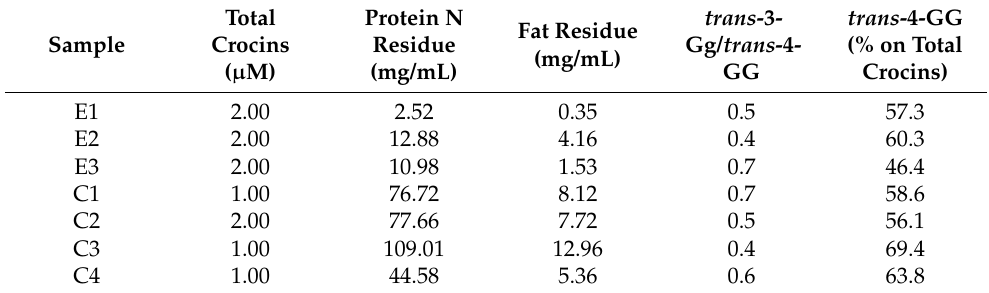
Table 2. Main characterization of the crocin-rich extracts incubated on the cellular lines: total crocins ( µ M) incubated; residual protein nitrogen (mg/mL) and fat (mg/mL); trans -3-Gg/ trans -4-GG ratio and trans -4-GG